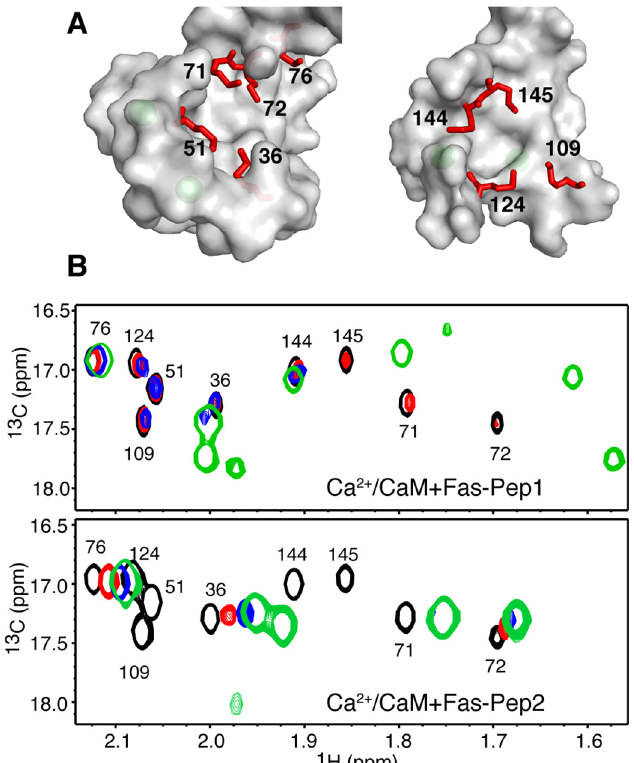
Fig 8. Role of Ca 2+ /CaM Met residues in binding of FasDD peptides. ( A ) Surface representation of the Ca 2+ /CaM structure (PDB ID: 3CLN) showing the nine Met residues localized in the N- and C-terminal lobes (red sticks). Ca 2+ ions are colored in green. ( B ) Overlay of a selected region of 2D 1 H- 13 C HMQC spectra obtained for 13 C-labeled Ca 2+ /CaM as a function of added Fas-Pep1 (top) or Fas-Pep2 (bottom). [peptide: Ca 2+ /CaM = 0:1 (black), 0.5:1 (red), 1:1 (blue), 1.5:1 (green)]. Only the 1 H- 13 C signals for the Met methyl groups are shown.